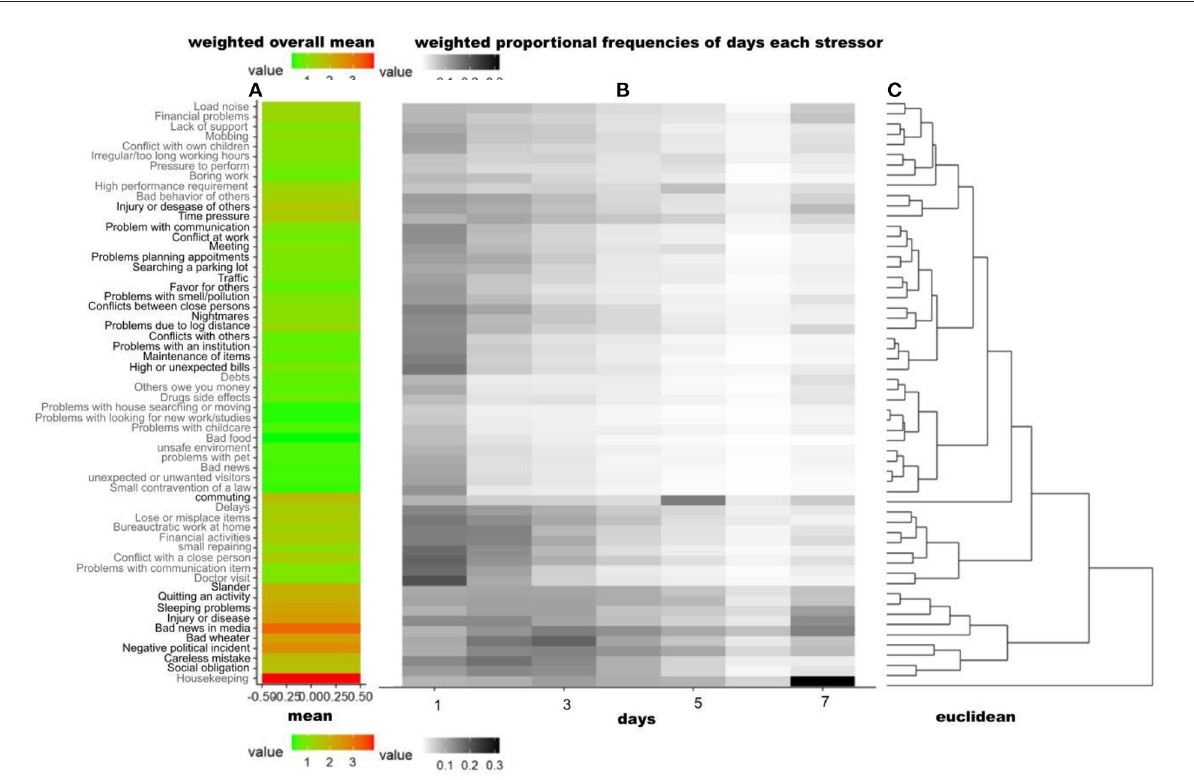
FIGURE2 DH fg Heat Map, indicating the overall and temporal frequencies of stressors (weighted DH fg ) vertically clustered by their temporal occurrence patterns. The figure consists of three parts: (A) showing the weighted overall mean of each item. (B) showing the weighted proportional frequencies of days each stressor was experienced–the darker the background, the more people experienced the stressor on the corresponding number of days (1–7): for example, “housekeeping” were experienced by many respondents on 7 days, “Doctor visit” was also reported to have been experienced once that week or some individuals reported “commuting” on 5 days. (C) Dendrogram indicating the difference between the items and their clusters of temporal patterns of relative frequencies. This cluster solution was also used to vertically sort the stressor items (using hierarchical clustering, euclidean distance and complete linkage). The proportional frequencies of each item (e.g., housekeeping 1 day: 10%, 2 days 13%, …, 7 days 30%) are successively merged into clusters. The fusion of different clusters is marked in the dendrogram by vertical lines. The heterogeneity within the clusters is plotted on the x-axis, it is growing with increasing cluster size. Longer horizontal lines indicate an increase in heterogeneity (of clusters) between the temporal occurrence patterns of the items: Cluster A includes 10 items (“loud noise” to “bad behavior of others”). Cluster B includes 17 items (“injury or disease of others” to “maintenance of items”). Cluster C includes 12 items (“Depts” to “small contravention of a law”). Cluster D includes 8 items (“Delays” to “Doctor visit”). Cluster E includes “commuting”. Cluster F includes 9 items (“slander” to “social obligation”), and Cluster G includes